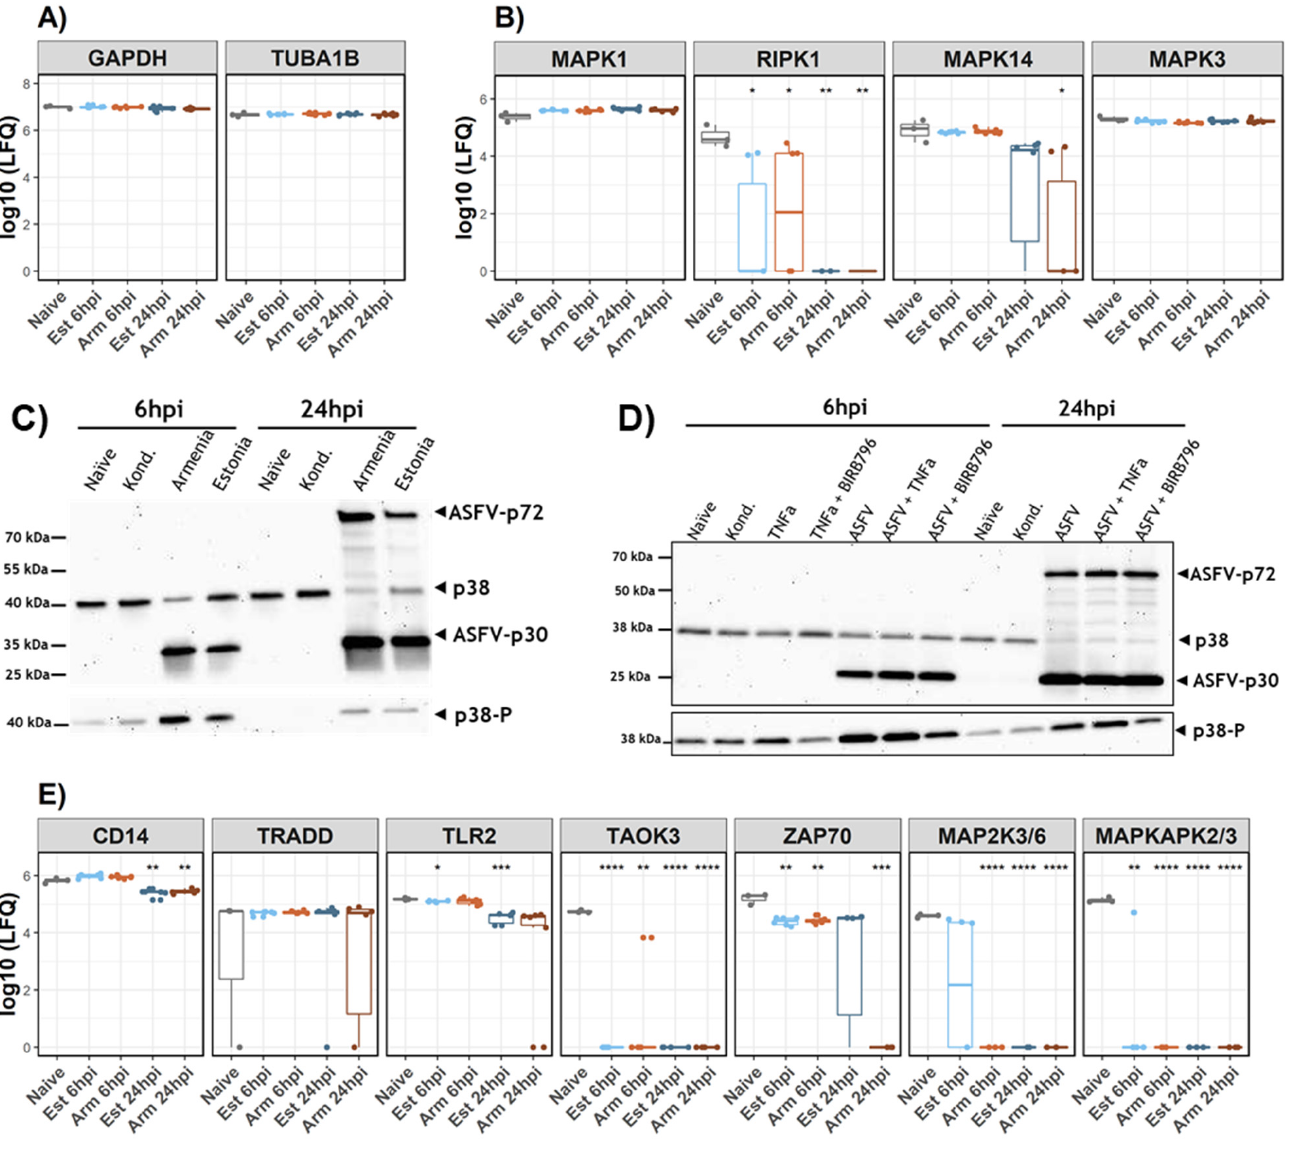
Figure 5. Expression levels of housekeeping genes GAPDH and TUBA1B ( A ) as references for de- scribed modulation of MAPK1, MAPK3, and MAPK14 levels ( B ) and genes involved in MAPK14/p38 signaling cascade ( E ) based on label-free quantification of MS data. ( C ) + ( D ) Immunoblot analysis of African swine fever virus (ASFV) gene products ASFV-p30 (early), ASFV-p72 (late), and MAPK14/p38 expression and its phosphorylated form in monocyte-derived macrophages (moM Φ ) after infection with Armenia 2008 (Arm) or Estonia 2014 (Est) with an MOI of 1 after 6 and 24 hpi. ( D ) To assess the impact of MAPK14/p38 pre-stimulation or inhibition during infection with Armenia 2008, moM Φ were treated with 20 ng/mL TNF α for 4 h or 25 nM BIRB796 during the infection period, respectively. Asterisks indicate p -values of 0.05 (*), 0.01 (**), 0.001 (***), and 0.0001 (****).